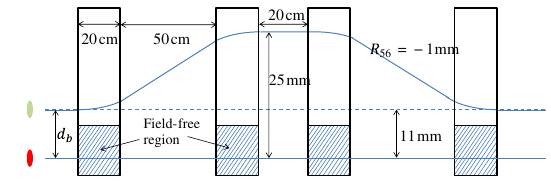
FIG. 5. A schematic layout of the delay chicane for the LCLS (not to scale). The largest transverse separation of the two orbits is 25 mm at R 56 ¼ − 1